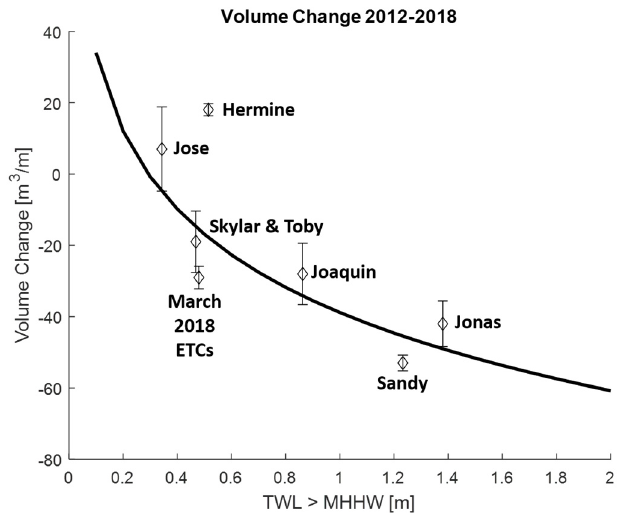
Figure 3. Normalized volumetric change ( Δ V ) at the site from 2012 to 2018 using various topobathymetric sensors and platforms. Individual TC and XC events are shown, as well as the combined values for the four XC occurring during March 2018. The fitted line shows the negative log relationship between the Δ V and the TWL MHHW for the events.